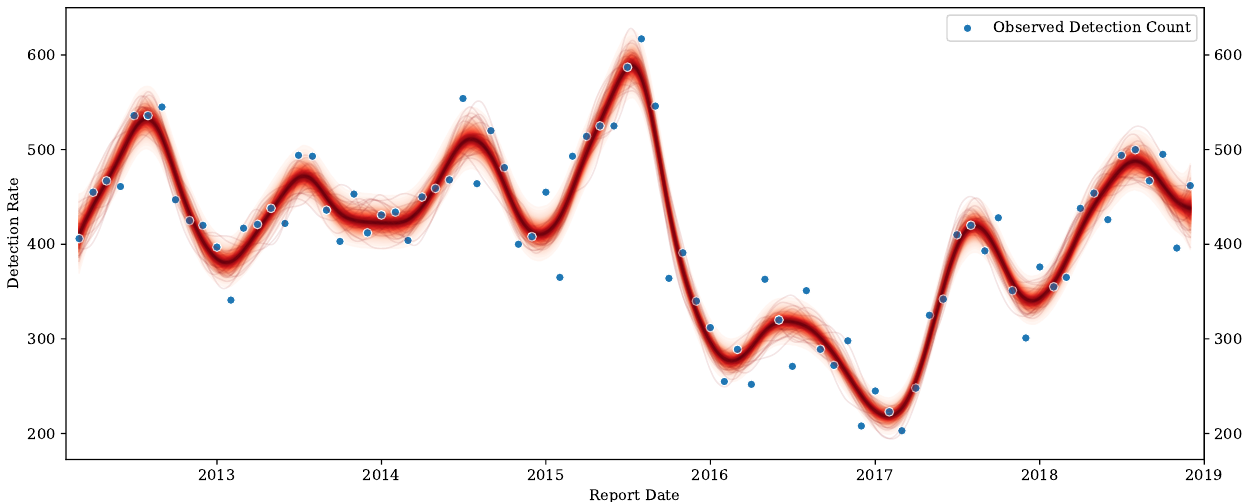
Figure 8. Posterior predictive samples showing the VIIRS detection count variations in North Dakota. Blue points stand for the observed data while red lines represent the posterior